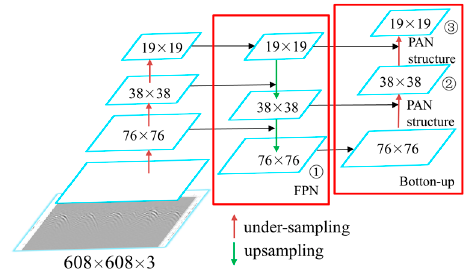
Figure 10. FPN + PANet structure. Figure 10. FPN+PANet structure.